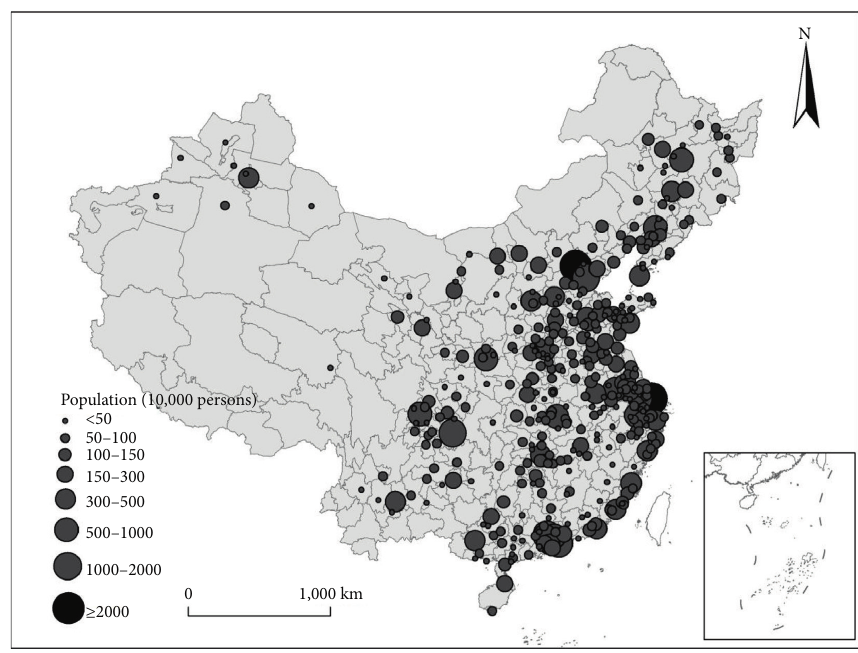
Figure 2: The spatial pattern of urban China in 2015. Table 1: 2015 summary statistics: cities with 300,000 inhabitants or more.